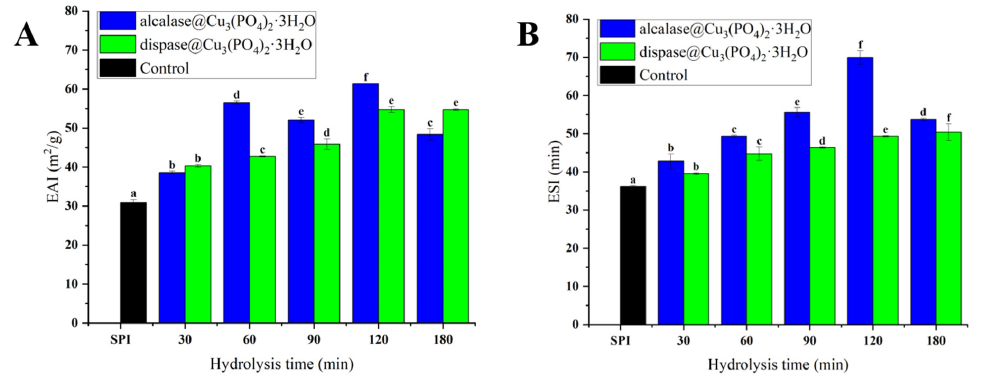
Figure 7. ACHNs, and DCHNs at different hydrolysis times: ( A ) EAI and ( B ) ESI. Different letters (a–f) represent significant differences between hydrolysates produced by the same enzyme hydrolysis at different times( p < 0.05).